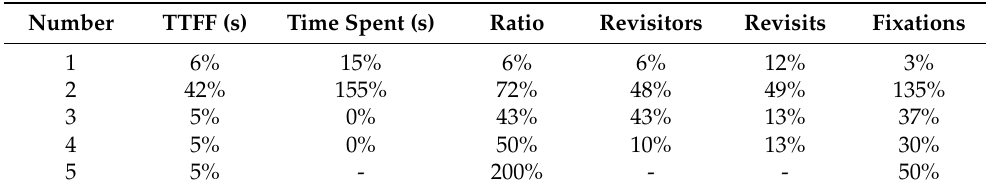
Table 8. Area of interest (AOI) metrics percentage difference: old vs. new website design. Note: the last AOI from the new website design was removed since it does not have a pair, but the order remained the same. Furthermore, percentages were truncated to no decimal places.